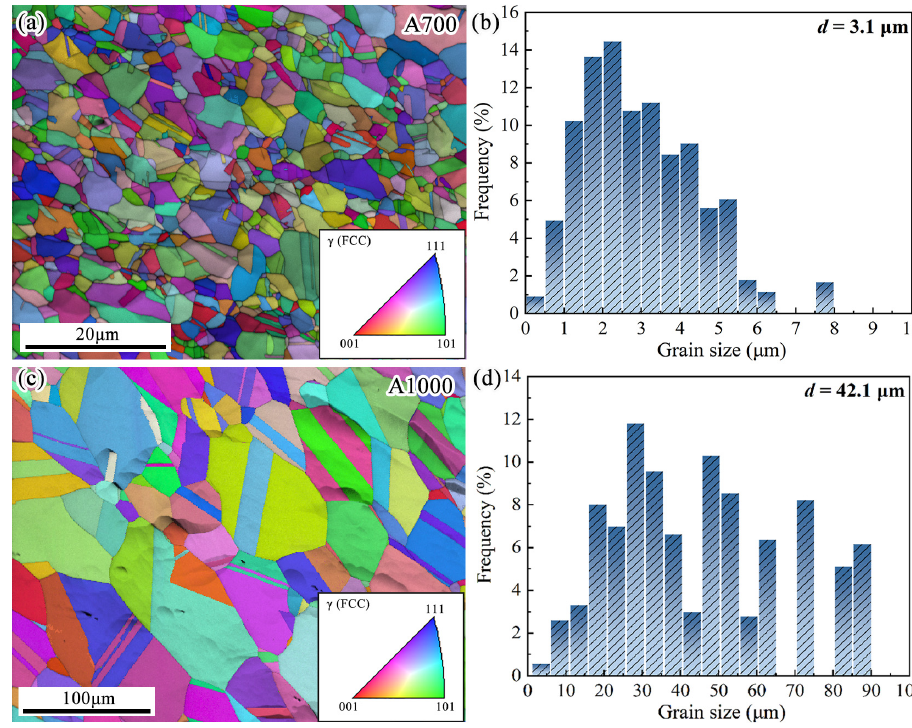
Figure 3. EBSD IPF + IQ maps and corresponding grain size distribution of ( a , b ) A700 and ( c , d ) A1000 specimens, respectively.